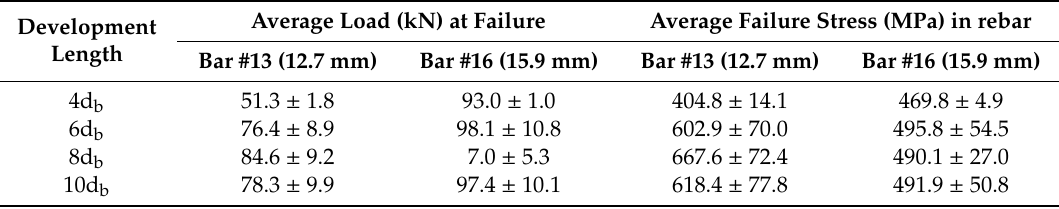
Table 3. Average Peak Load and Rebar Stress at Failure for Pull-Out